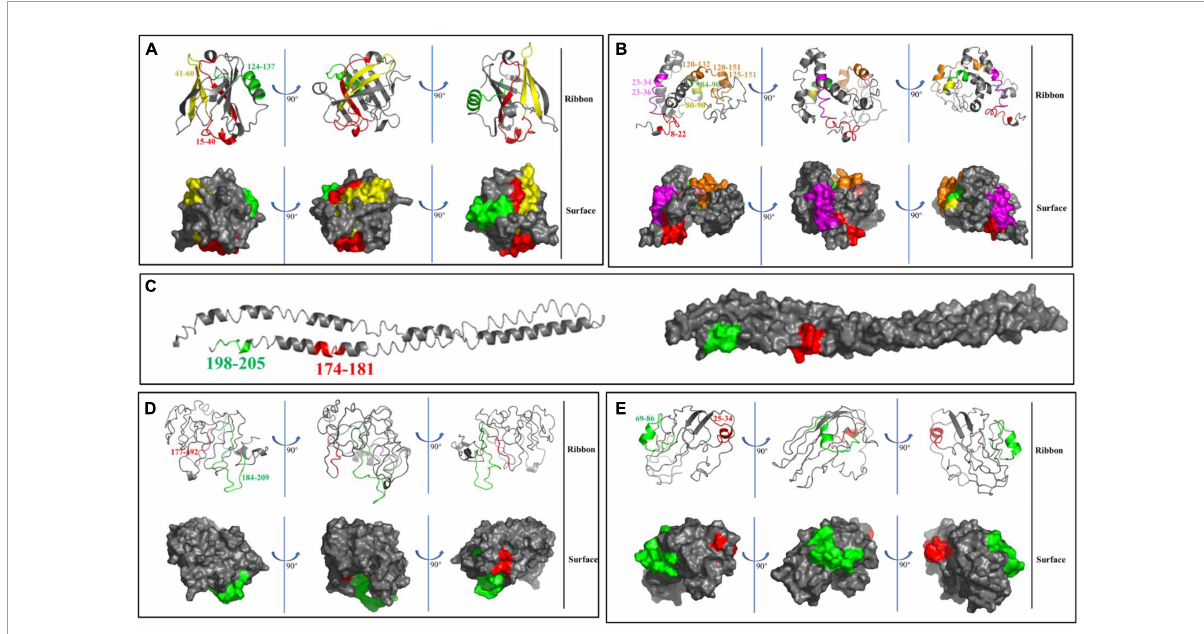
FIGURE6 Mapping of peptides on the spatial structure of Bos d 5 (A) , Bos d 9 (B) , Bos d 10 (C) , Bos d 11 (D) , and Bos d 12 (E) by using ribbon and surface diagrams based on Pymol visualization